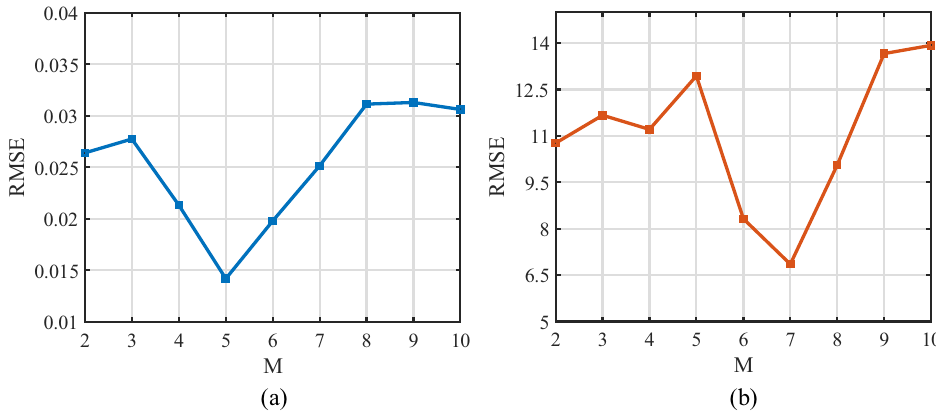
Figure 8: The RMSE values of the test set of vMF - WSAE vary with di ff erent choices of M at ( a ) carbon content and ( b ) temperature.